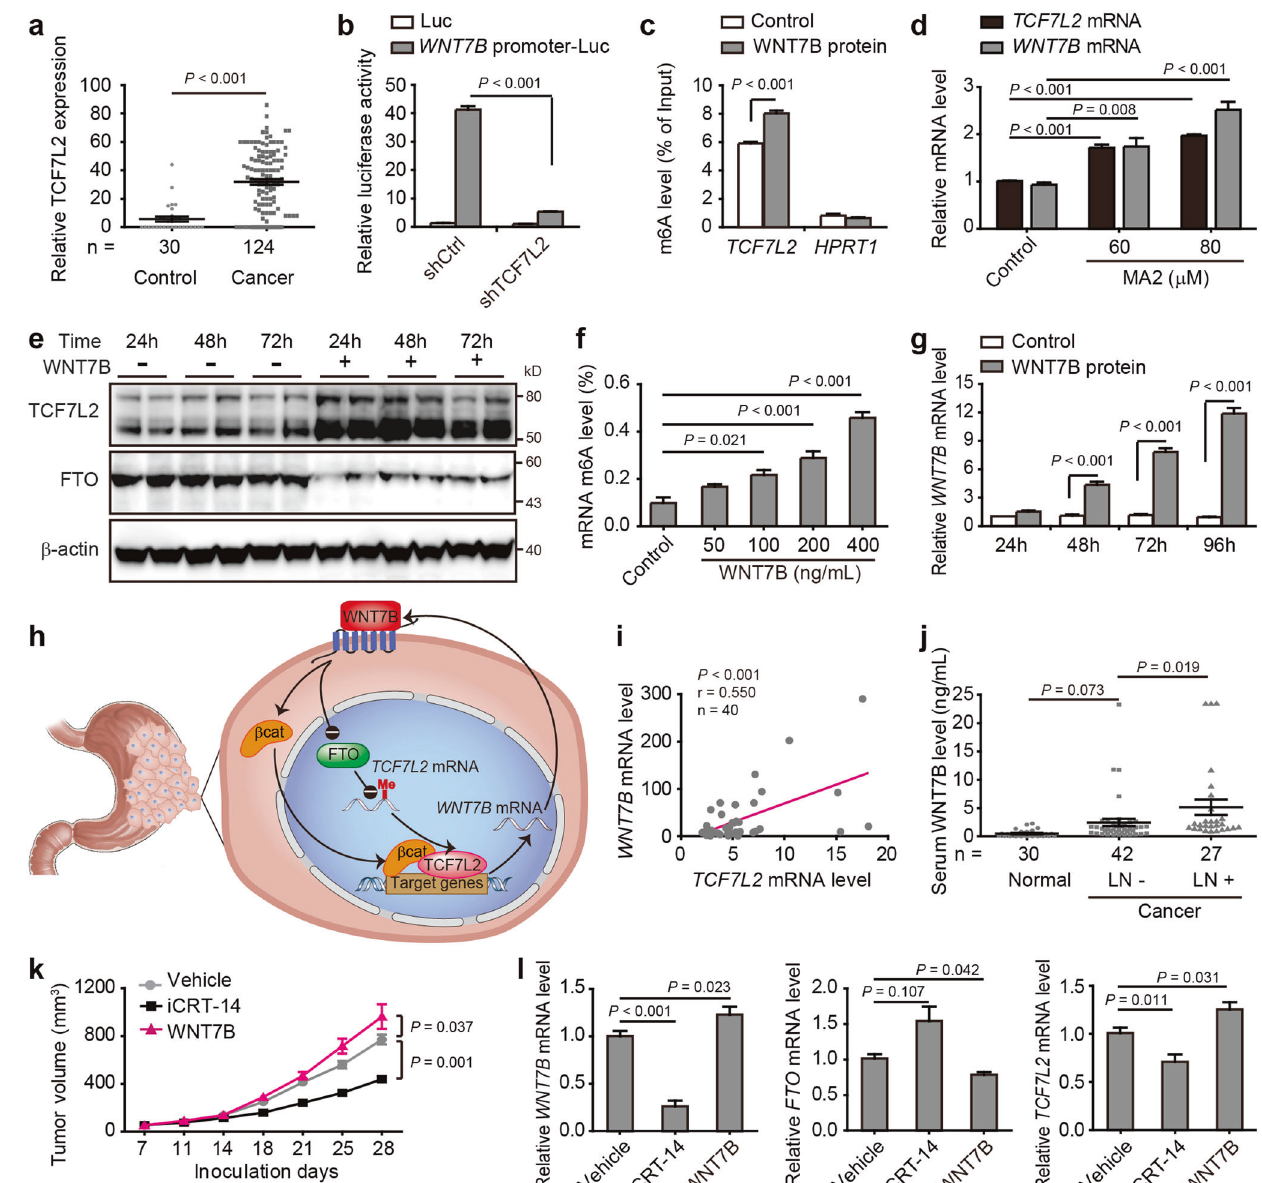
Fig. 1 The role of the WNT7B-m6A-TCF7L2 positive feedback loop in gastric cancer metastatic progression. a Immunohistochemical staining of TCF7L2 protein in gastric tissues from patients with gastric cancer (Cancer) and chronic gastritis (Control) was quantitatively measured using Image J software. b Luciferase reporter assay for WNT7B promoter in N87 cells transfected with TCF7L2 shRNA. c m 6 A methylation of TCF7L2 mRNA in N87 cells treated with WNT7B protein (200 ng/mL) for 48 h was analyzed by gene-speci fi c m 6 A-RIP-qPCR. HPRT1 served as a negative control. d mRNA levels of TCF7L2 and WNT7B in N87 cells treated with MA2 for 48 h were analyzed by qRT-PCR. e Expression of TCF7L2 and FTO at the indicated time points (two biological replicates for each) was analyzed by immunoblotting in N87 cells treated with WNT7B protein (200 ng/mL). f ELISA-based assay for quanti fi cation of global m 6 A levels in N87 cells treated with WNT7B for 48 h. g Levels of WNT7B mRNA at indicated time points were analyzed by qRT-PCR in N87 cells treated with WNT7B protein (200 ng/mL). h Proposed working model of the WNT7B-m 6 A-TCF7L2 positive feedback loop. i Correlation between WNT7B and TCF7L2 mRNA levels in cancer tissues from patients with gastric cancer. j Levels of WNT7B protein in the serum of healthy people undergoing health check-ups (Normal), gastric cancer patients without lymph node metastasis (LN − ), and those with lymph node metastasis (LN + ) were analyzed by ELISA. k PDX tumor growth curves for vehicle-, iCRT-14-, and WNT7B-treated mice are shown. N = 6 mice per group. l mRNA levels of WNT7B , FTO , and TCF7L2 in PDX tumors from vehicle-, iCRT-14-, and WNT7B-treated mice were analyzed by qRT-PCR. P values were calculated with the unpaired Student t test ( a - c , g ), one-way ANOVA with post hoc LSD test ( d , f , j , l ), Pearson ’ s correlation test ( i ), or two-way repeated-measure ANOVA